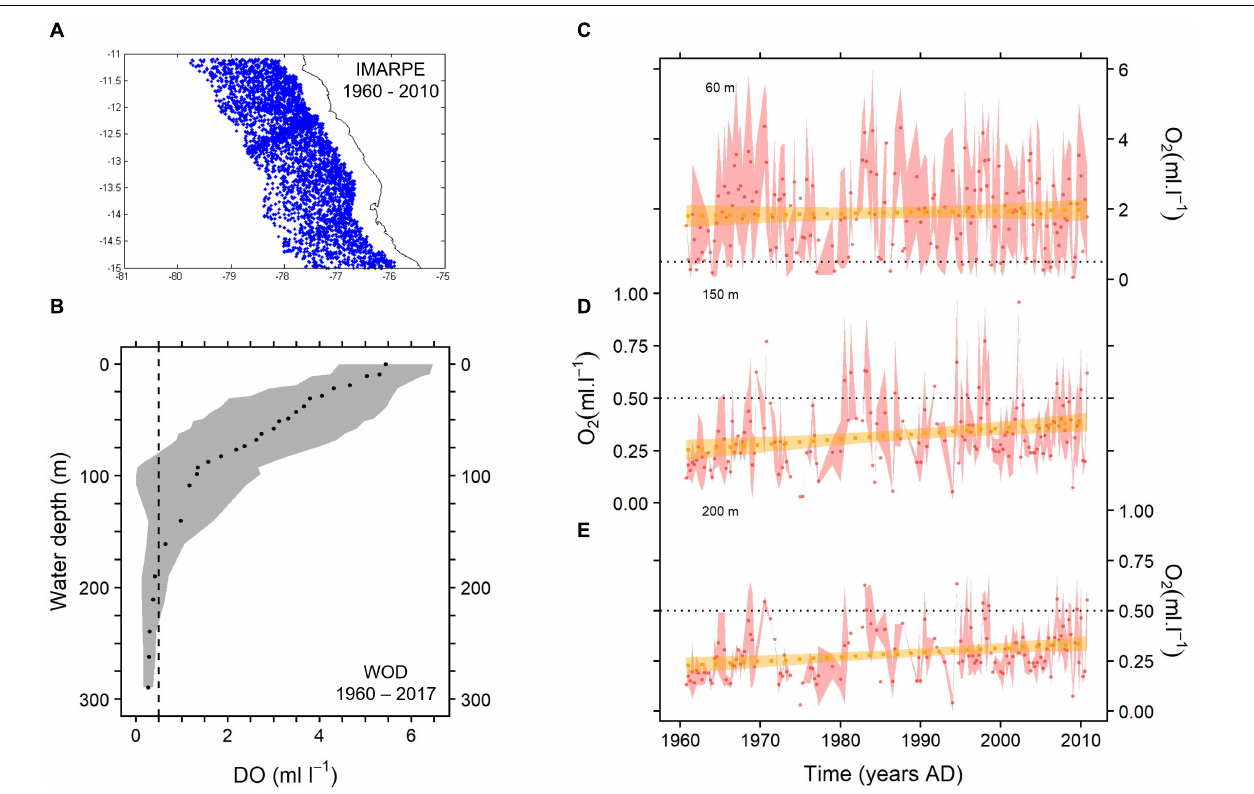
FIGURE 2 | Time series (1960 – 2010) of dissolved oxygen off central Peru. (A) Map showing the IMARPE oceanographical stations between 30 and 100 NM and 11 and 15 ◦ S. (B) Mean dissolved oxygen profile with error values in the water column for the area depicted in (A) (data available in World Ocean Database 2018). Time series of dissolved oxygen at 60 m (C) , 150 m (D) and 200 m (E) depth. Red areas indicate error values. Trend lines with confidence intervals (orange) for each depth are